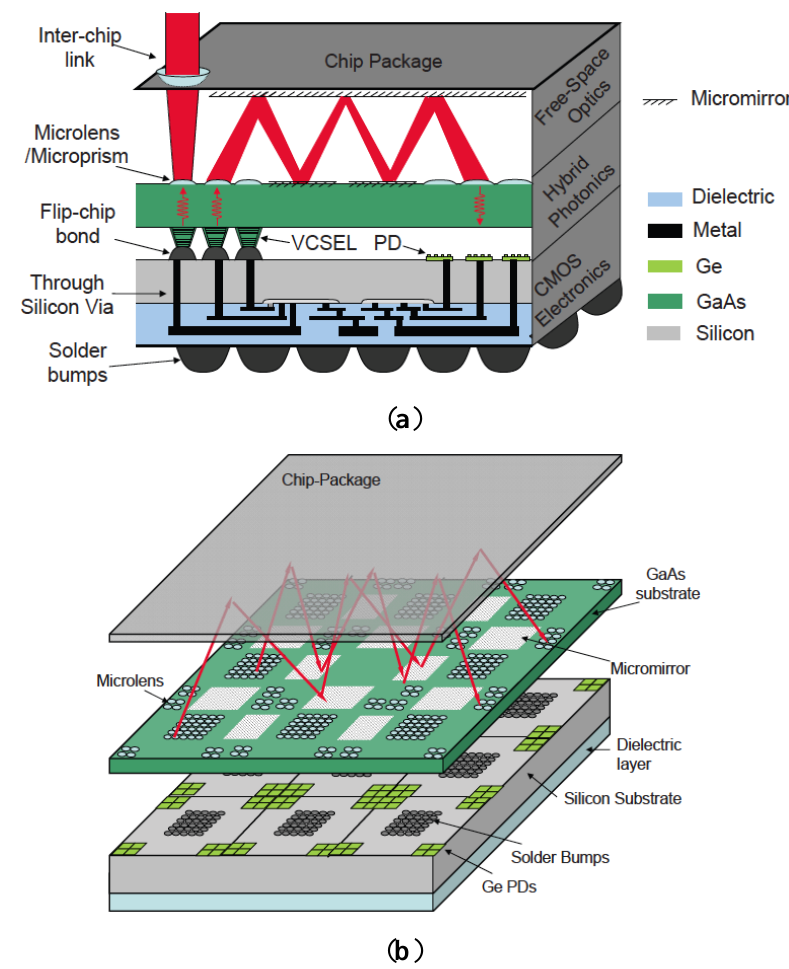
Figure 1. ( a ) Cross-sectional and ( b ) three-dimensional view of a typical microsystem that consists of electronic ( i.e. , complementary metal-oxide-semiconductor (CMOS) transceivers and amplifiers), optic ( i.e. , lenses and mirrors) and photonic (lasers and photodetectors) components with packages [35] (Reproduced with permission from Ciftcioglu et al. , Opt. Express ; published by OSA,